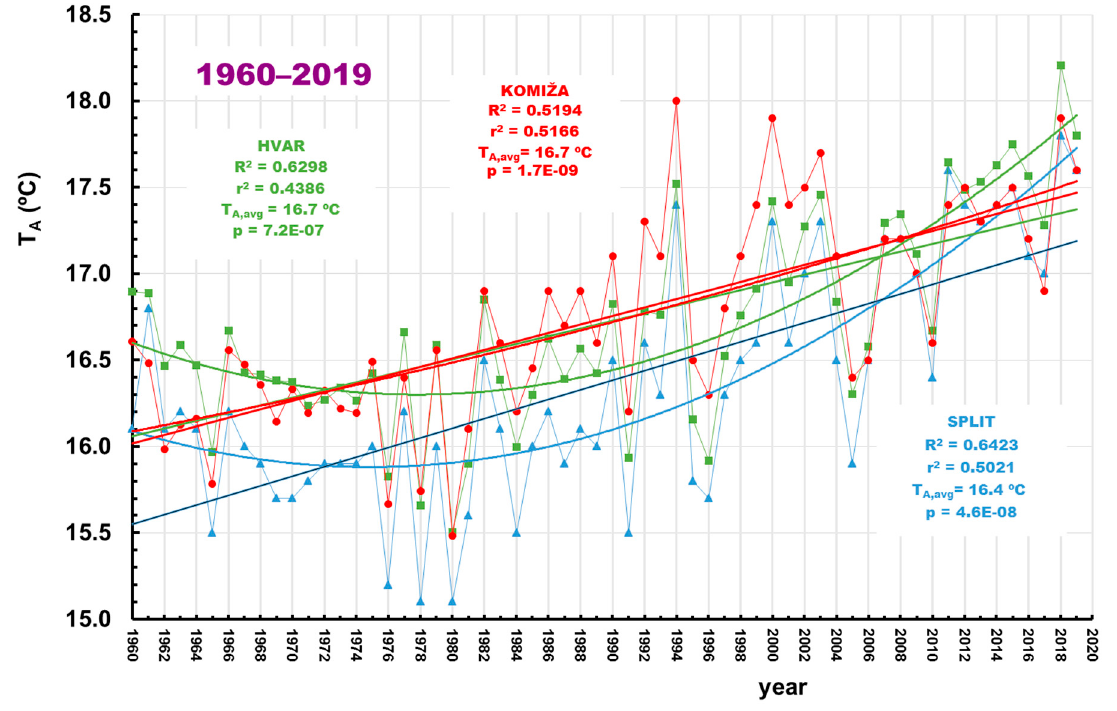
Figure 4. Time series of the mean annual air temperature measured at Split, Hvar, and Komiža stations. The r 2 and R 2 represent the square values of the correlation coefficients of the linear and quadratic regressions, respectively, and p represents M–K test values. T A, avg is the average value of the mean annual air temperature in the investigated period.